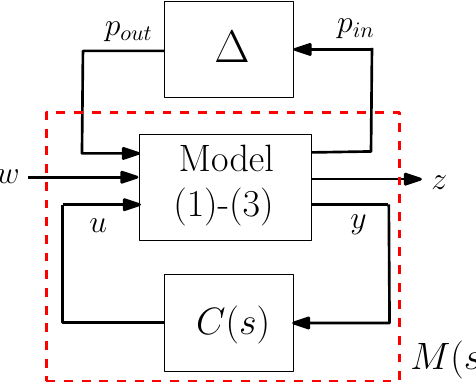
Figure 5. M - ∆ standard representation for µ